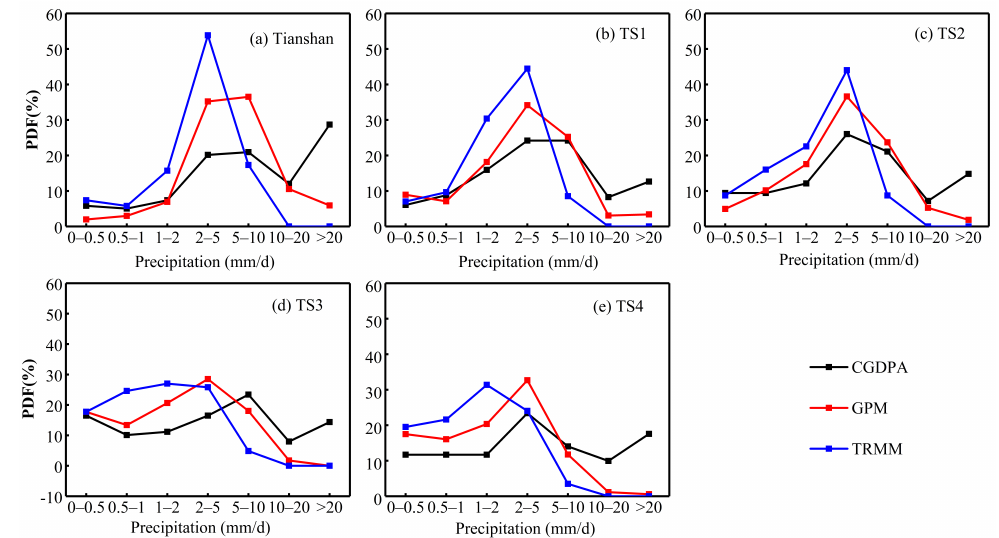
Figure 8. Probability density function (PDF) of precipitation estimation in Tianshan and four subregions.